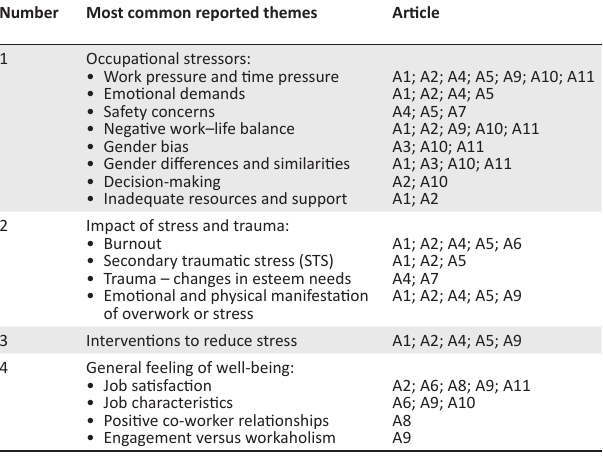
TABLE 2: Summary of